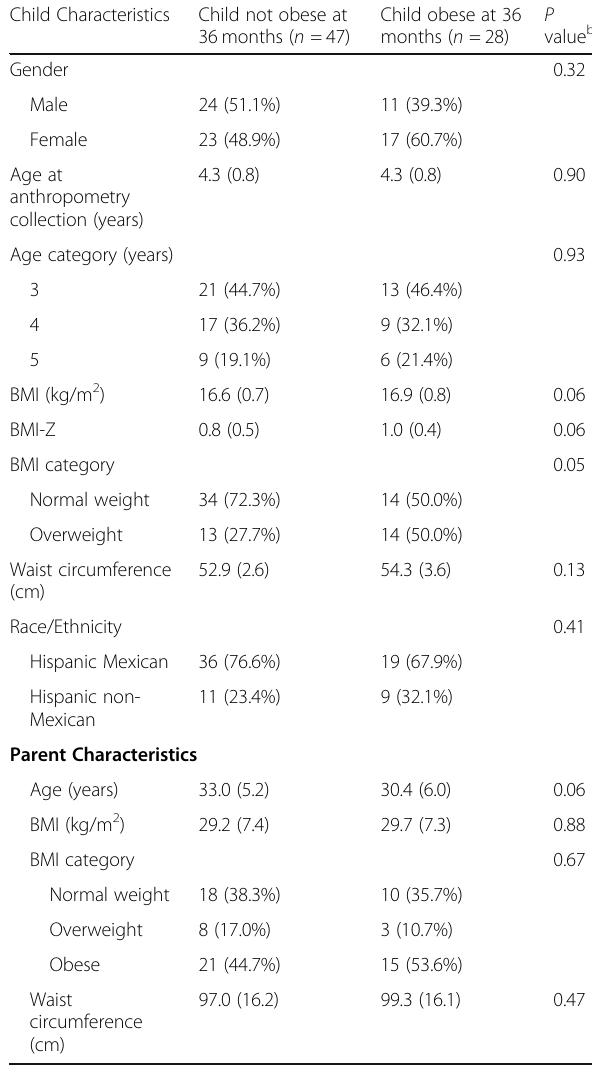
Table 1 Demographics of Sample Population a Child Characteristics